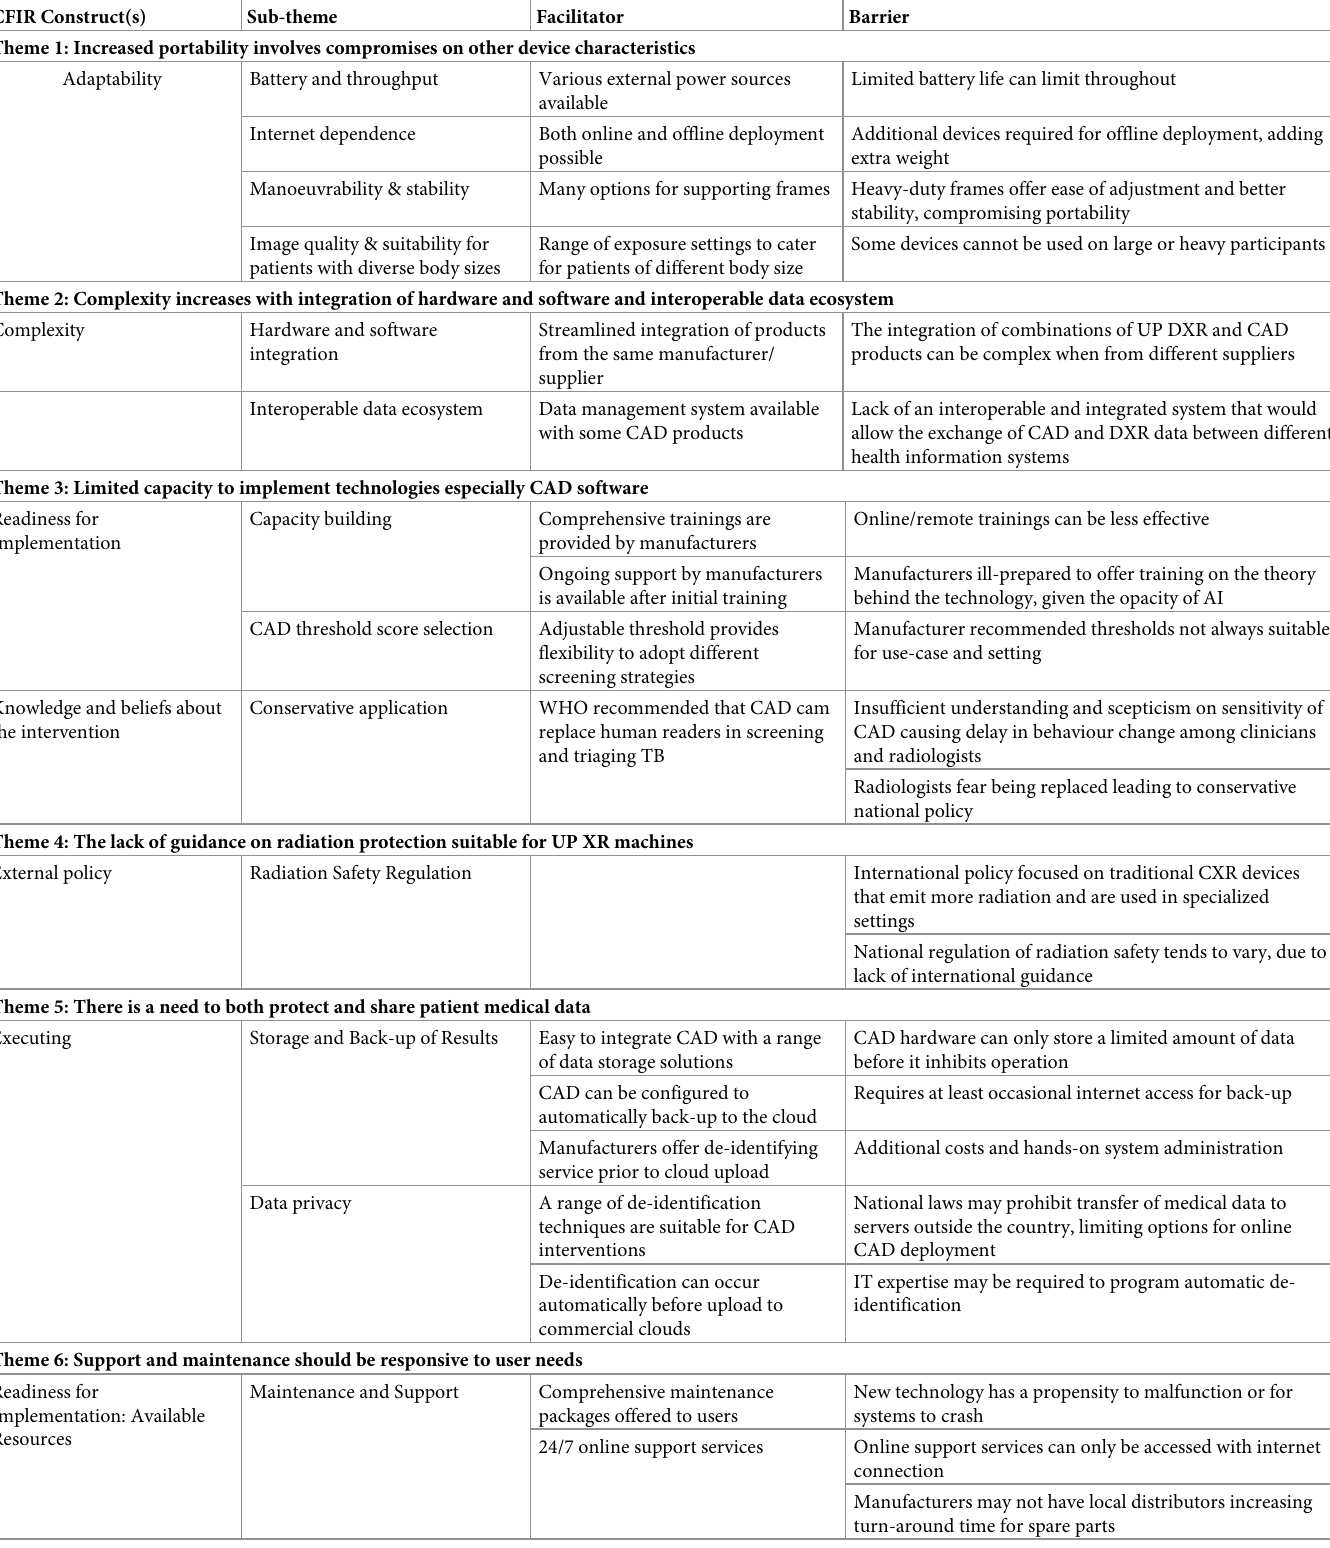
Table 3. Barriers and facilitators to the implementation of DXR-CAD, presented along the